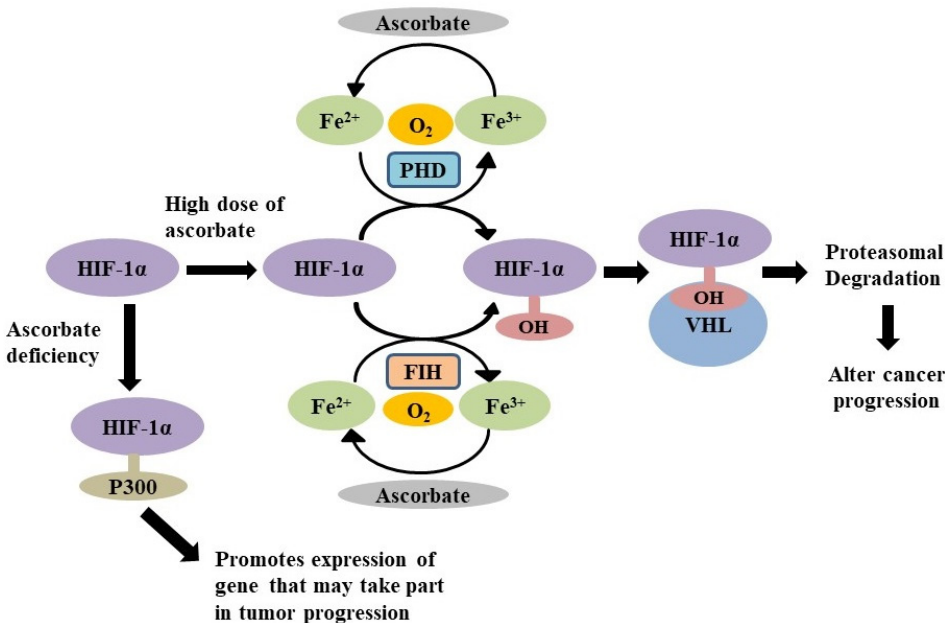
Figure 6. Ascorbate regulates HIF-1 α by recycling Fe 2+ required for the function of PHDs and FIH, leading to alteration of cancer progression [34,35,37,41,42]. leading to alteration of cancer progression